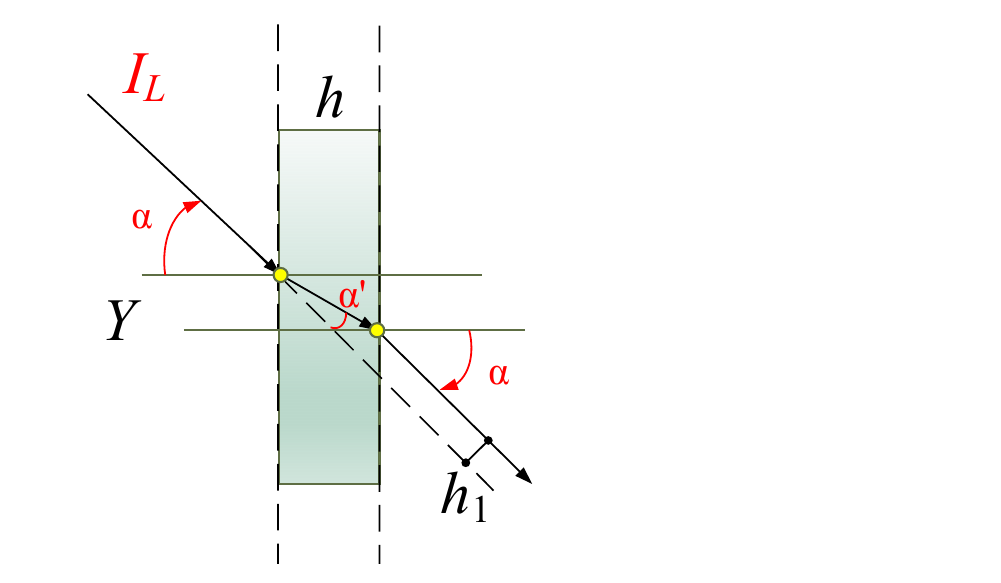
Figure 7. The thickness of recording window 3 (on Figure 2) based on the refraction of the beam. ∝ = n , where n is the refractive index equal to the It follows from Snellius’ law that sin sin ∝ (cid:48) quartz plate n = 1.52 for the wavelength λ = 2 mkm [39]. For the seed detection range